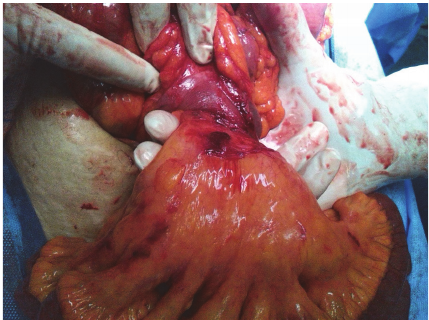
Figure 3: Intestinal malrotation with midgut